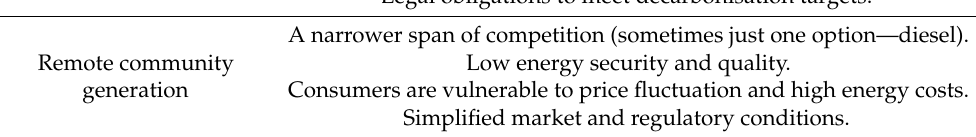
Table 3. Market characteristics [26]. Market Characteristics Attractive but also very competitive. Utility-scale generation